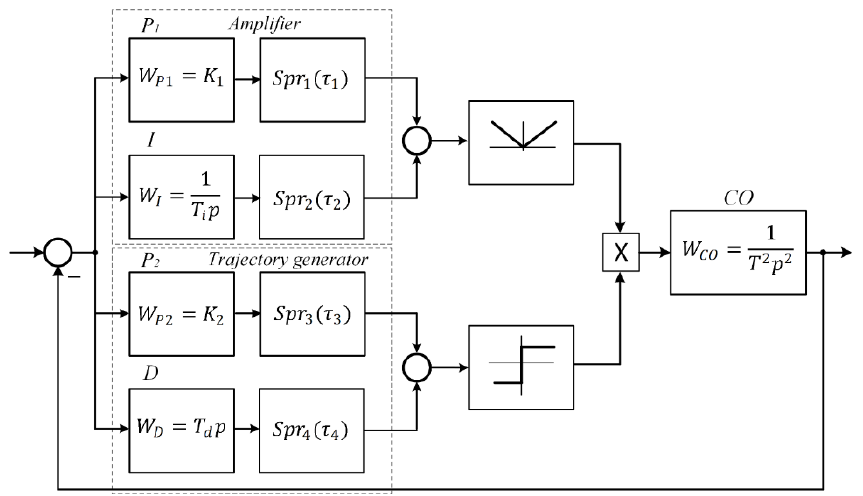
Figure 9. Block diagram of an VSS with sliding processes with separate sampling channels in the controller.